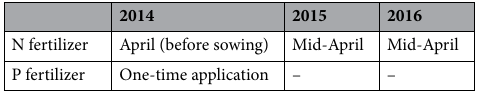
Table 5. Fertilization